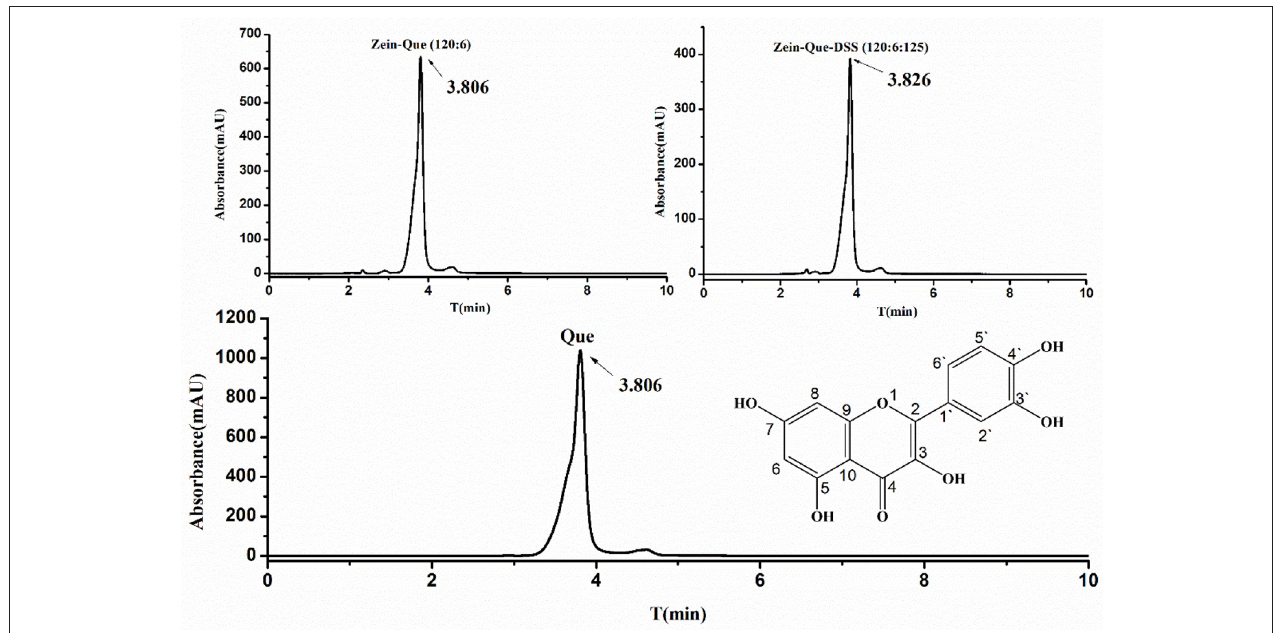
FIGURE 2 | The chemical structural formula of quercetin, HPLC chromatogram of free Que, and Que supernatant obtained from Zein-Que (120:6) nanoparticles and Zein-Que-DSS (120:6:125) complex nanoparticles.